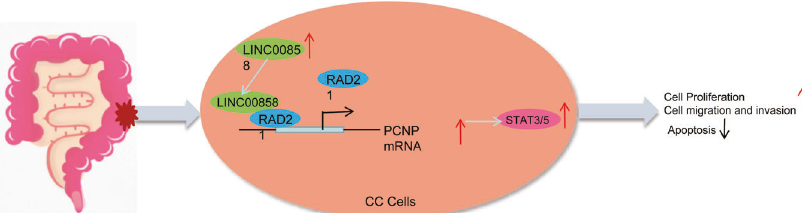
Fig. 7 Schematic diagram of the mechanism by which LINC00858 affects colon cancer. LINC00858 can recruit the transcription factor RAD21, which in turn binds to the PCNP promoter to promote PCNP transcription and expression, thereby activating the STAT3/5 signaling pathway, promoting the proliferation, migration, and invasion of colon cancer cells, inhibiting their apoptosis, and ultimately promoting colon cancer